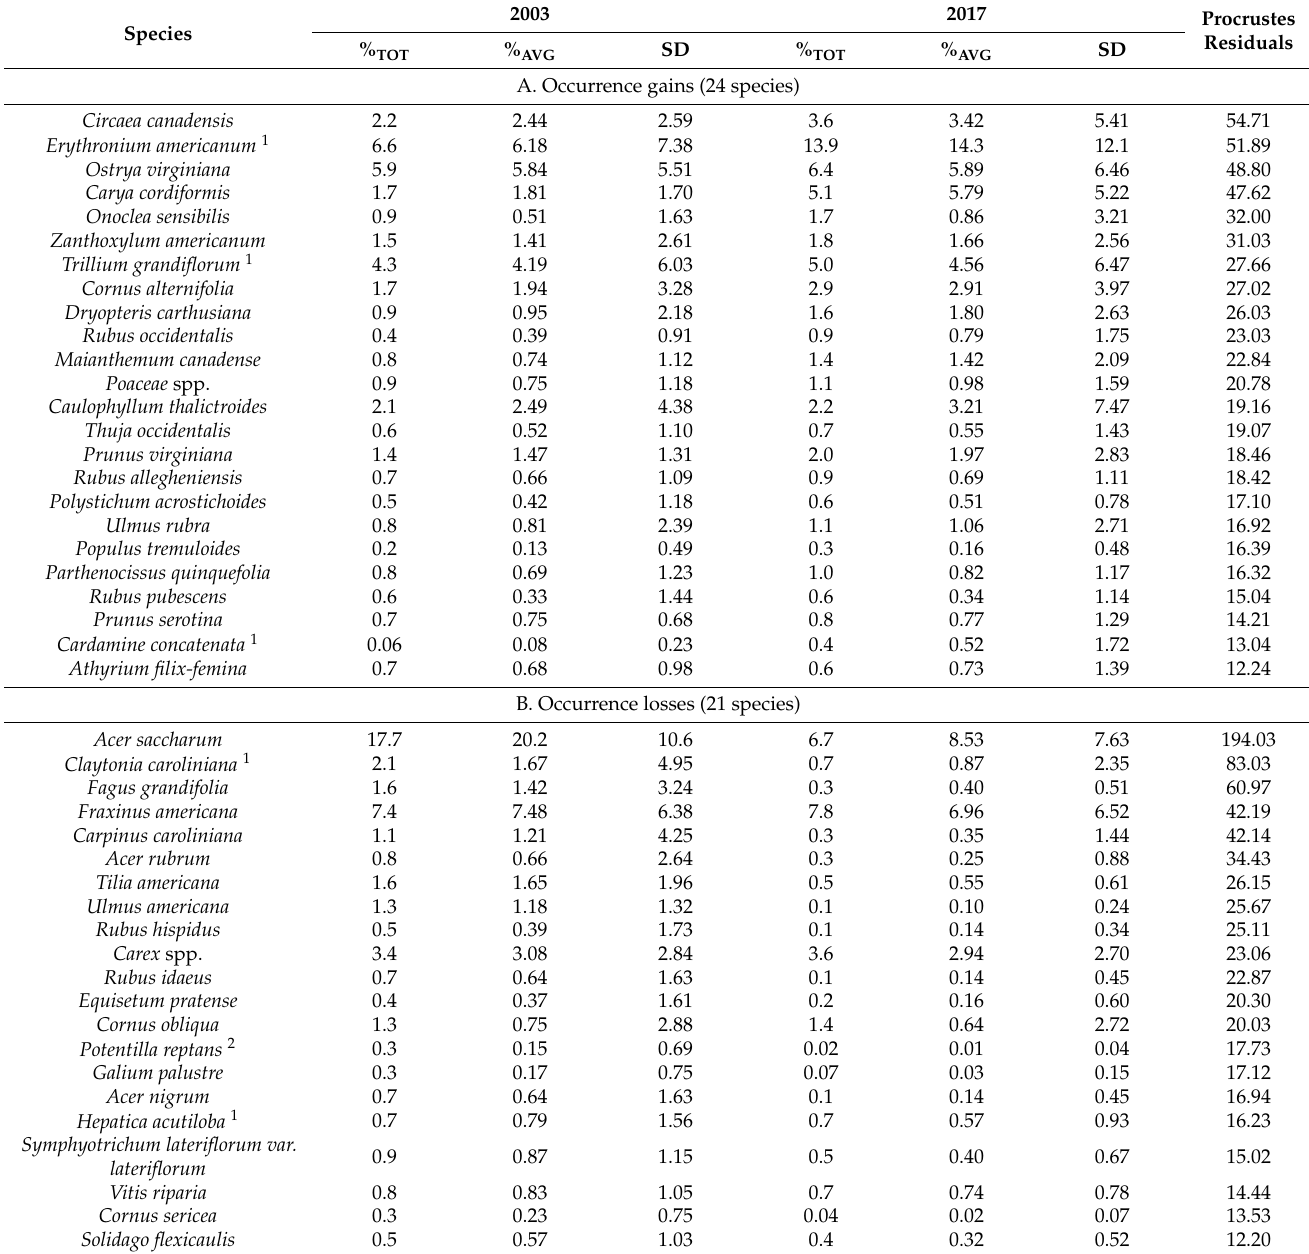
Table 3. Comparison of average values and standard deviation (SD) of the relative proportion in stand total occurrences (% AVG ) between the 2003 and 2017 inventories of understory communities for species that underwent the largest (A) gains or (B) losses of occurrence. Each species’ relative proportion in the total vegetation across stands (i.e., all 20 study sites combined; % TOT ) for both years and Procrustes residual value are also represented. Only species with a Procrustes residual value ≥ 80th percentile are shown (see Table S4 for list of all plant